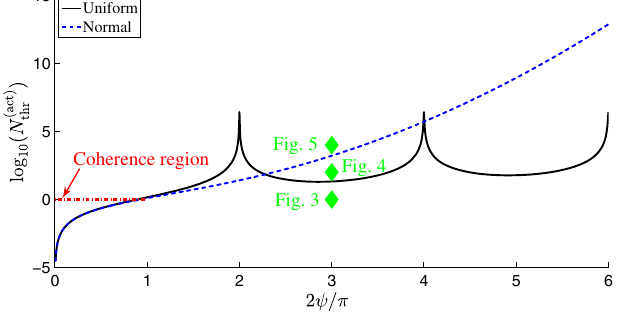
FIG. 6. The threshold of electron number in a microbunch (shown in a logarithmic scale) as function of the phase-spread of the electrons for uniform phase distribution (solid black curve) and for normal phase distribution (blue dashed curve). For the uniform distribution the phase is spread over the range of ð − ψ ; ψ Þ ffiffiffiffiffi p 12 with standard deviation of 2 ψ = . For the normal distribution the phase is spread over the range of ð −∞ ; ∞ Þ with the same standard deviation as the uniform